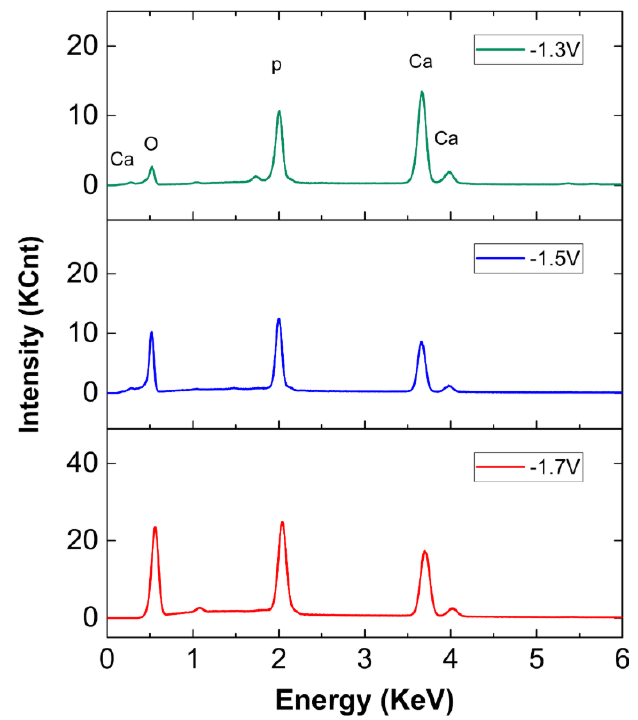
Figure A1. Typical EDS spectra of HAp coatings deposited on the weave under different electrodeposition potentials.